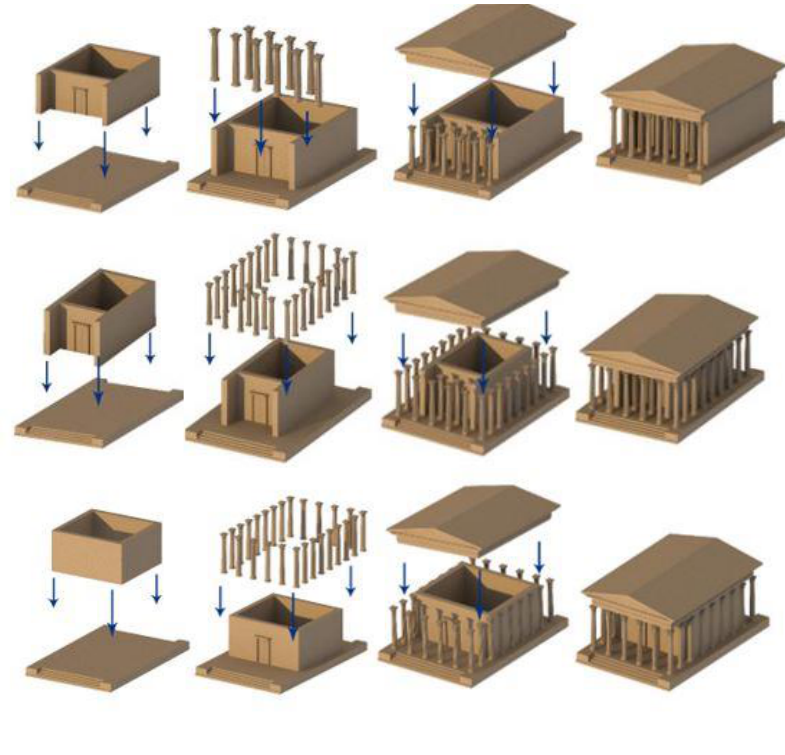
Figure 12 3 Temple